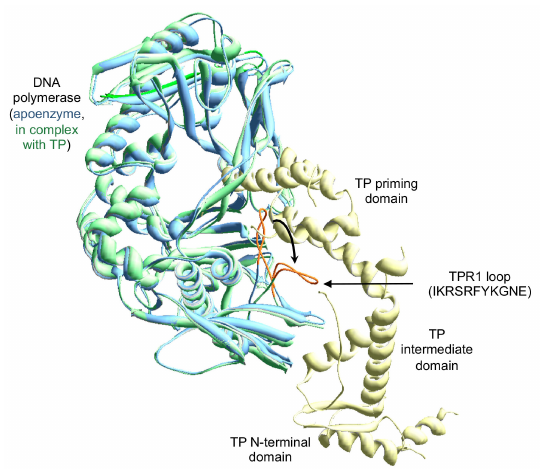
Figure 1. Movement of the Phi29 DNA polymerase TPR1 loop to allow the placement of the terminal protein (TP) priming domain. The figure was made by superimposing the structure of the DNA polymerase complexed with the TP [16] (PDB (Protein Data Base) code 2EX3) on the apo enzyme [10] (PDB code 1XHX). The DNA polymerase from the heterodimer and the apo enzyme are colored in green and blue, respectively. TP is colored in pale yellow. The TPR1 loop is colored in orange, and its sequence (from residue 304 to 314) is